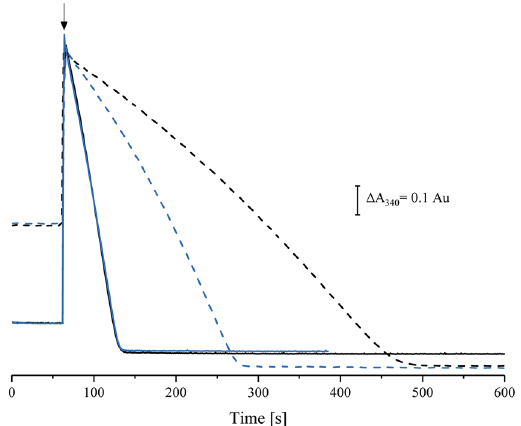
Figure 5. NADH:ferricyanide oxidoreductase activity of 10 nm isolated complex I (black) and 10 nm isolated V96P/N142M E variant (blue). The assays contained 150 µ m NADH and 1 mm ferricyanide in 50 mm MES/NaOH, 50 mm NaCl, pH 6.0. The reaction was either started by an addition of NADH (solid lines) or ferricyanide (dashed lines) when indicated (arrow).